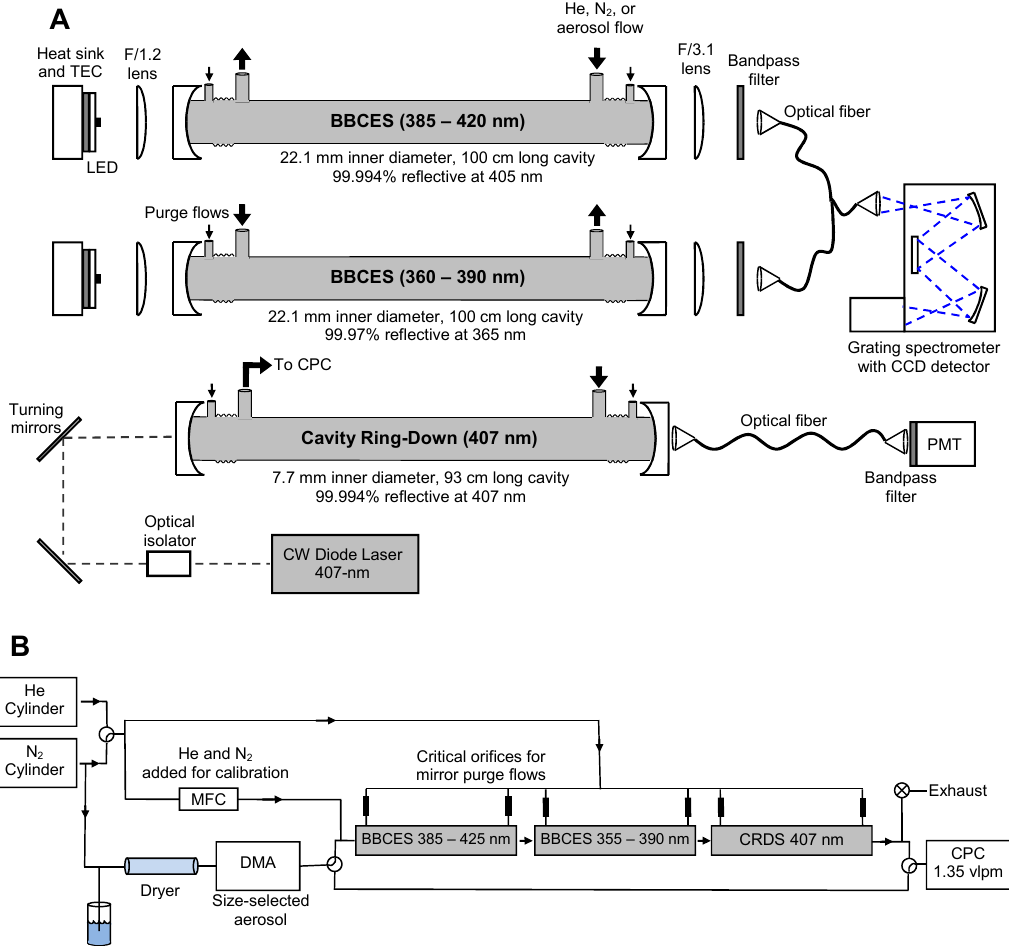
Fig. 1. (a) Schematic of the broadband cavity enhanced spectrometer, with channels for 360–390 and 385–420nm. Each BBCES channel consists of a temperature-controlled LED and optical cavity, with a shared grating spectrometer. Details of the 407nm CRDS are given in Fuchs et al. (2009). (b) Block diagram showing aerosol generation and gas delivery. Aerosols are generated with an atomizer, and subse- quently dried and size-selected using a differential mobility analyzer (DMA). The aerosol concentration is measured using a condensation Figure 1. particle counter